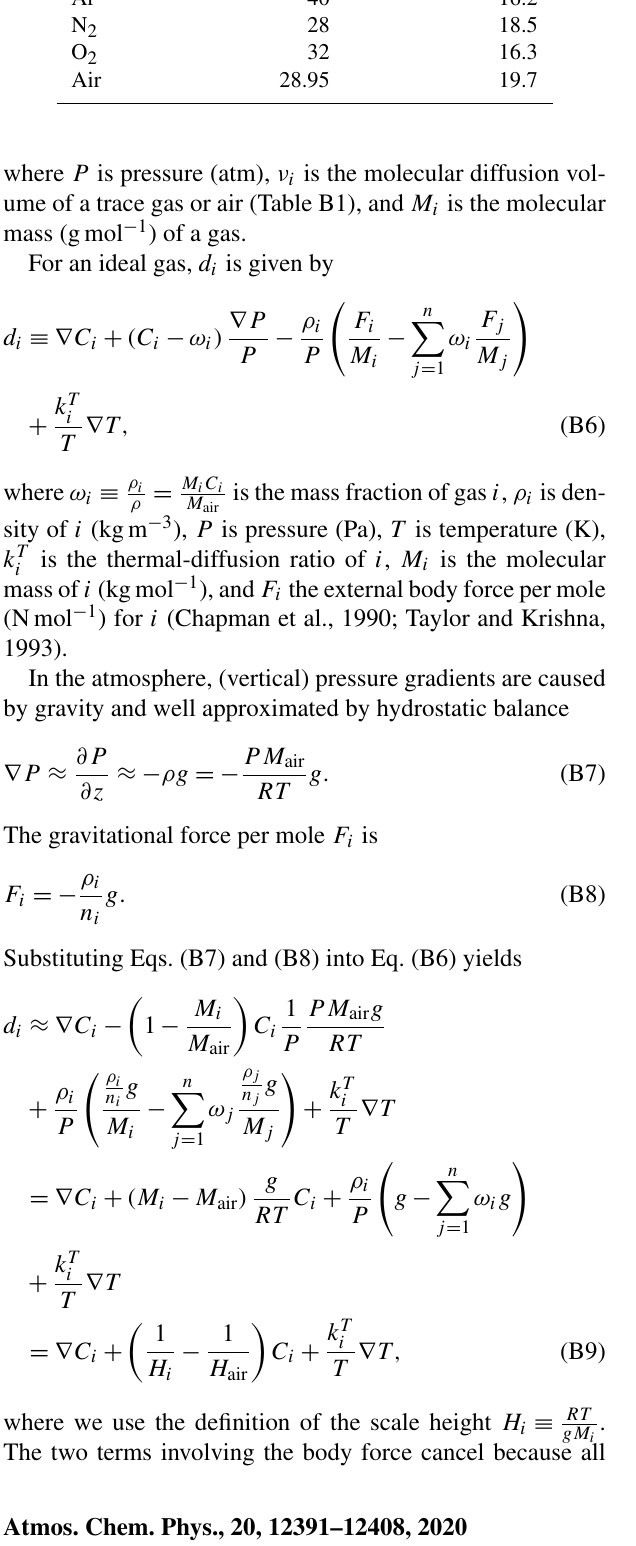
Table B1. Molecular diffusion volumes (Reid et al., 1987) and masses used in this study. Chemical Molecular mass Molecular diffusion species (gmol − 1 ) volume Ar 40 16.2 N 2 28 18.5 O 2 32 16.3 Air 28.95